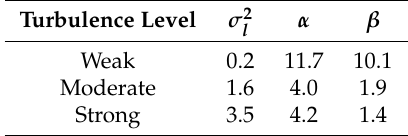
Table 1. Atmospheric turbulence parameters